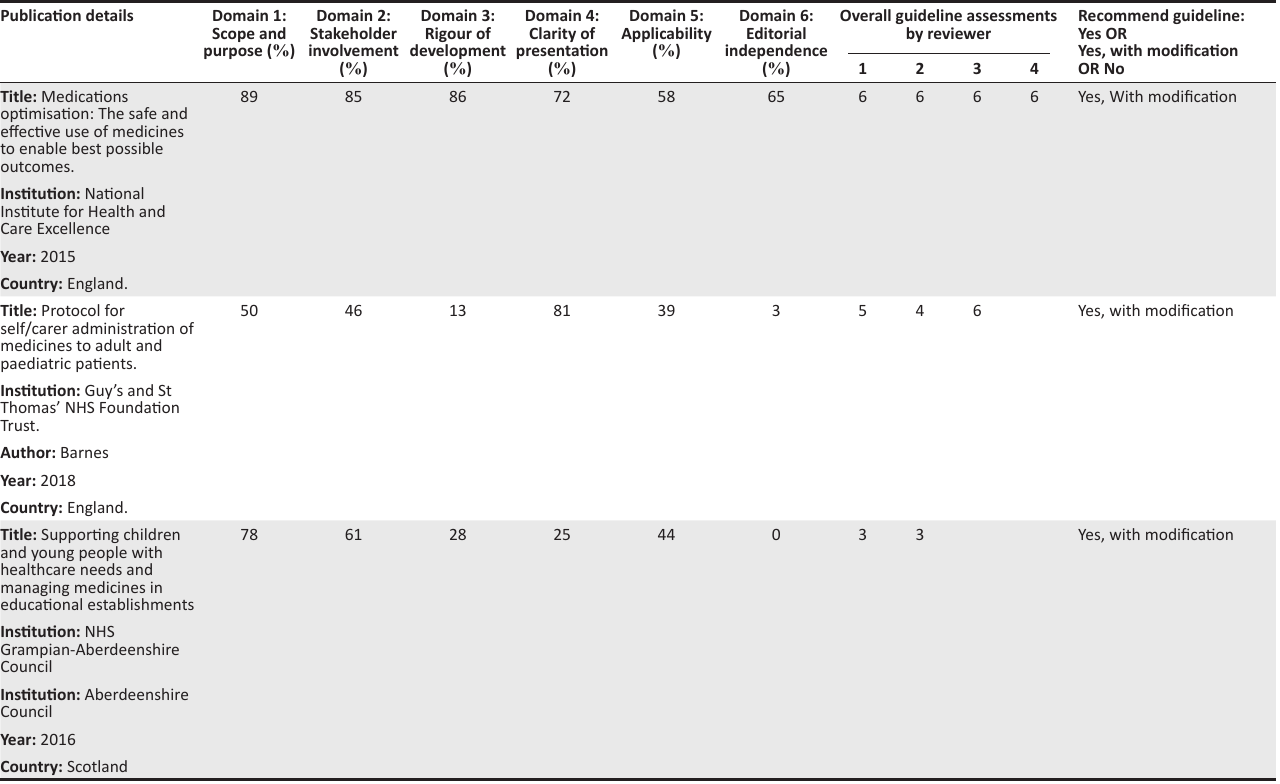
TABLE 1: Domain scores obtained following guideline appraisal using the AGREE II